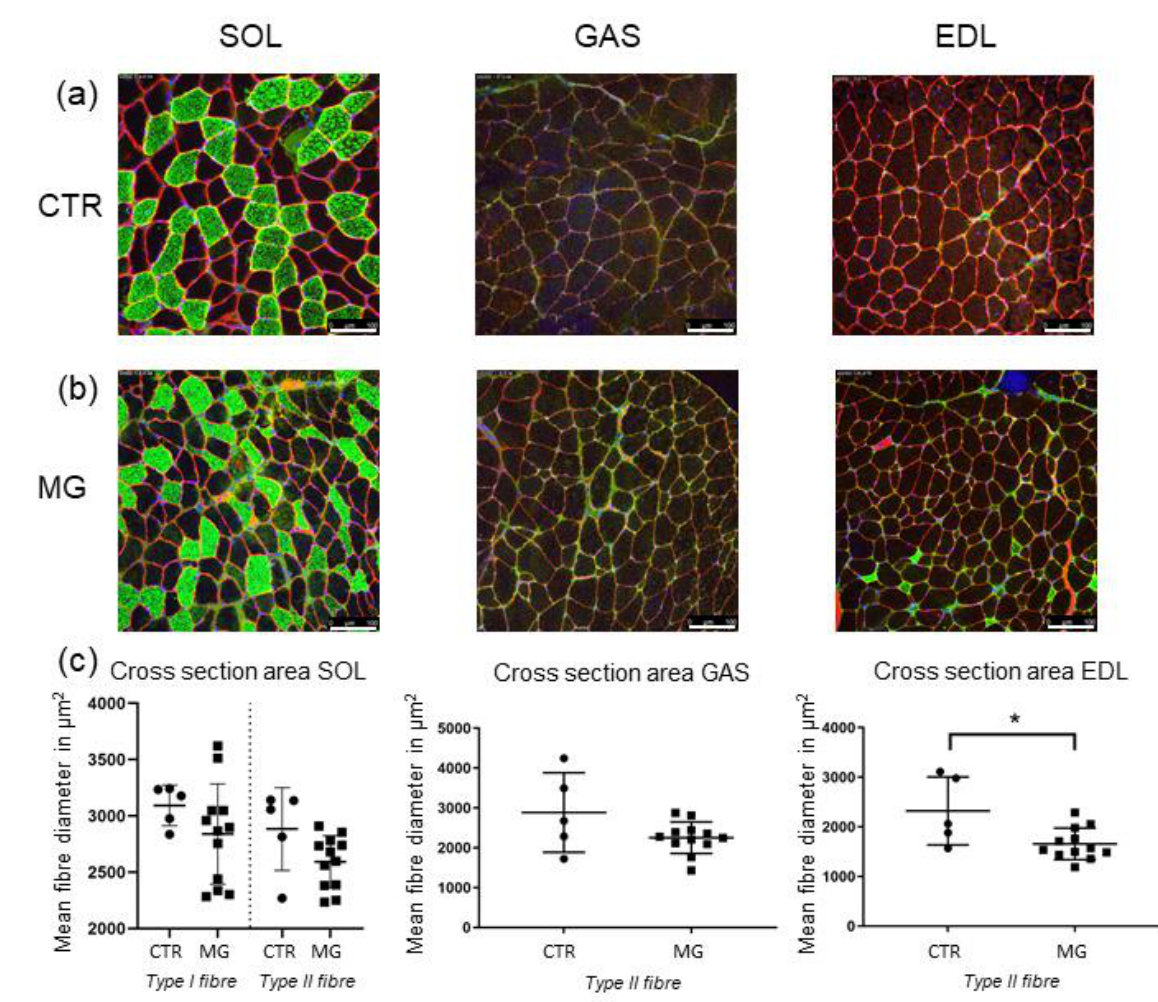
Figure 9. Muscle fibre cross-sectional area/morphometry analysis. ( a , b ): Staining of muscle sections of each SOL , GAS, and EDL with Dystrophin (red), Myosin slow (green) and DAPI (blue). The upper panel a) representing CTR animals while lower panel b) contains sections of EAMG-affected mice muscle. ( c ): Cross-section area statistical analysis: No significant reduction of muscle fibre diameter could be detected in both SOL and GAS muscle (SOL: p ≤ 0.08; GAS : p ≤ 0.23). In EDL ( c ), a significant reduction of mean fibre diameter could be detected in EAMG-animals compared to CTR group ( p ≤ 0.037). In all three muscle groups absolute mean diameter is lower in MG than in CTR group. Type- I-fibres could only be statistically analysed in SOL muscle, in GAS and EDL samples slow-type fibres were not or only sparsely detectable. Thus, in GAS and EDL only Type-II-fibre diameter was ana- lysed. In all analyses n = 5 for CTR, n = 12 for EAMG. * indicates significant difference vs CTR.